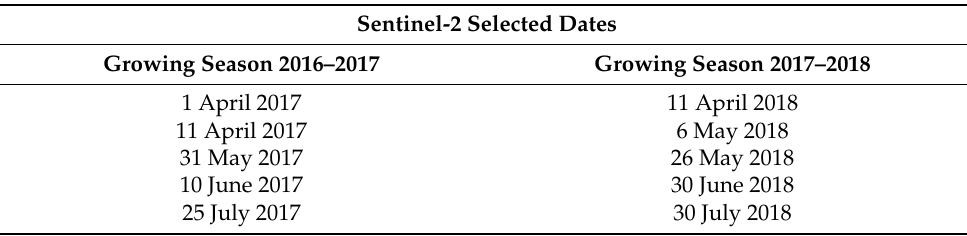
Table 3. Selected dates (based on crop phenological stages) of Sentinel-2 images for the study area located in the south Mediterranean–Kondar,